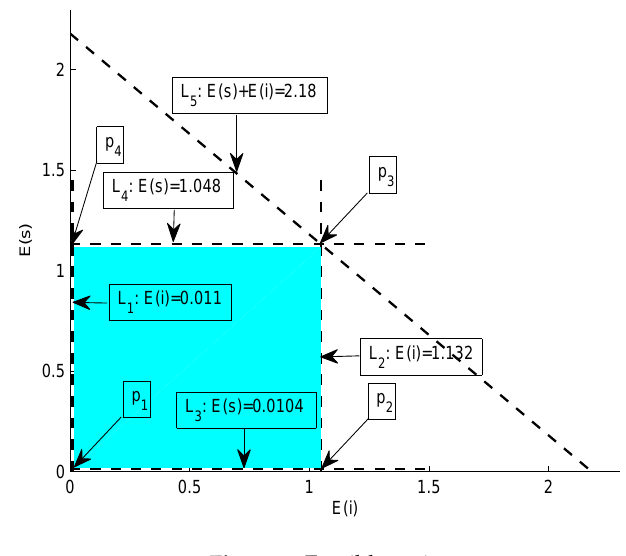
Figure 6. Feasible